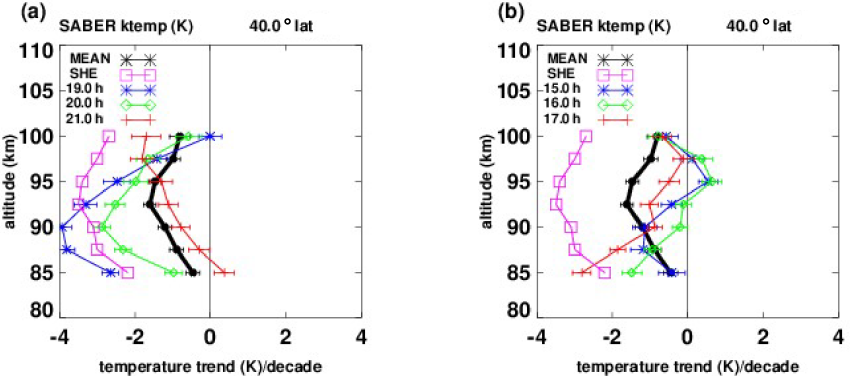
Figure 5. Temperature trends (K per decade) vs. altitude, at 40 ◦ N latitude. (a) Black asterisks: trends based on SABER zonal mean (over longitude and local time); blue asterisks, green diamonds, red plus symbols: trends based on SABER zonal means at 19:00, 20:00, 21:00LT. Magenta squares: trends based on nighttime lidar measurements by She et al. (2019); (b) as in (a) but for SABER results at 15:00, 16:00,